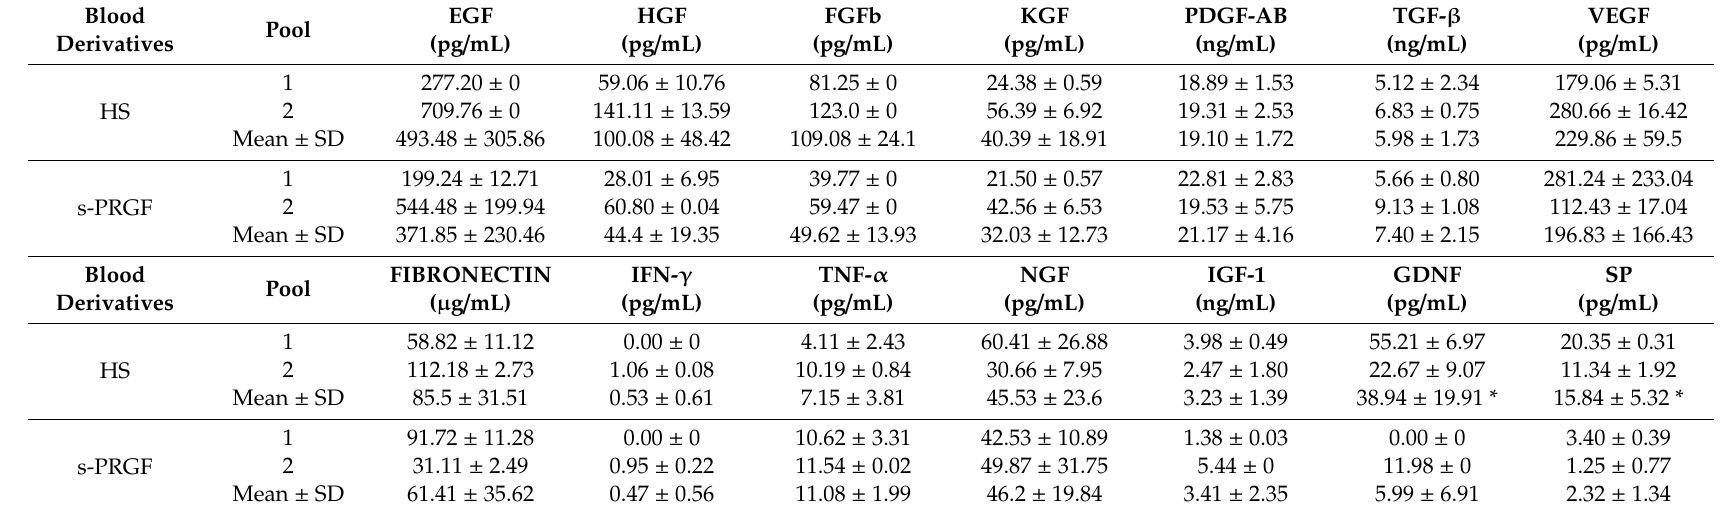
Table 1. The concentration of growth factors and other molecules in two di ff erent pools of the human blood derivatives—HS and s-PRGF. Blood